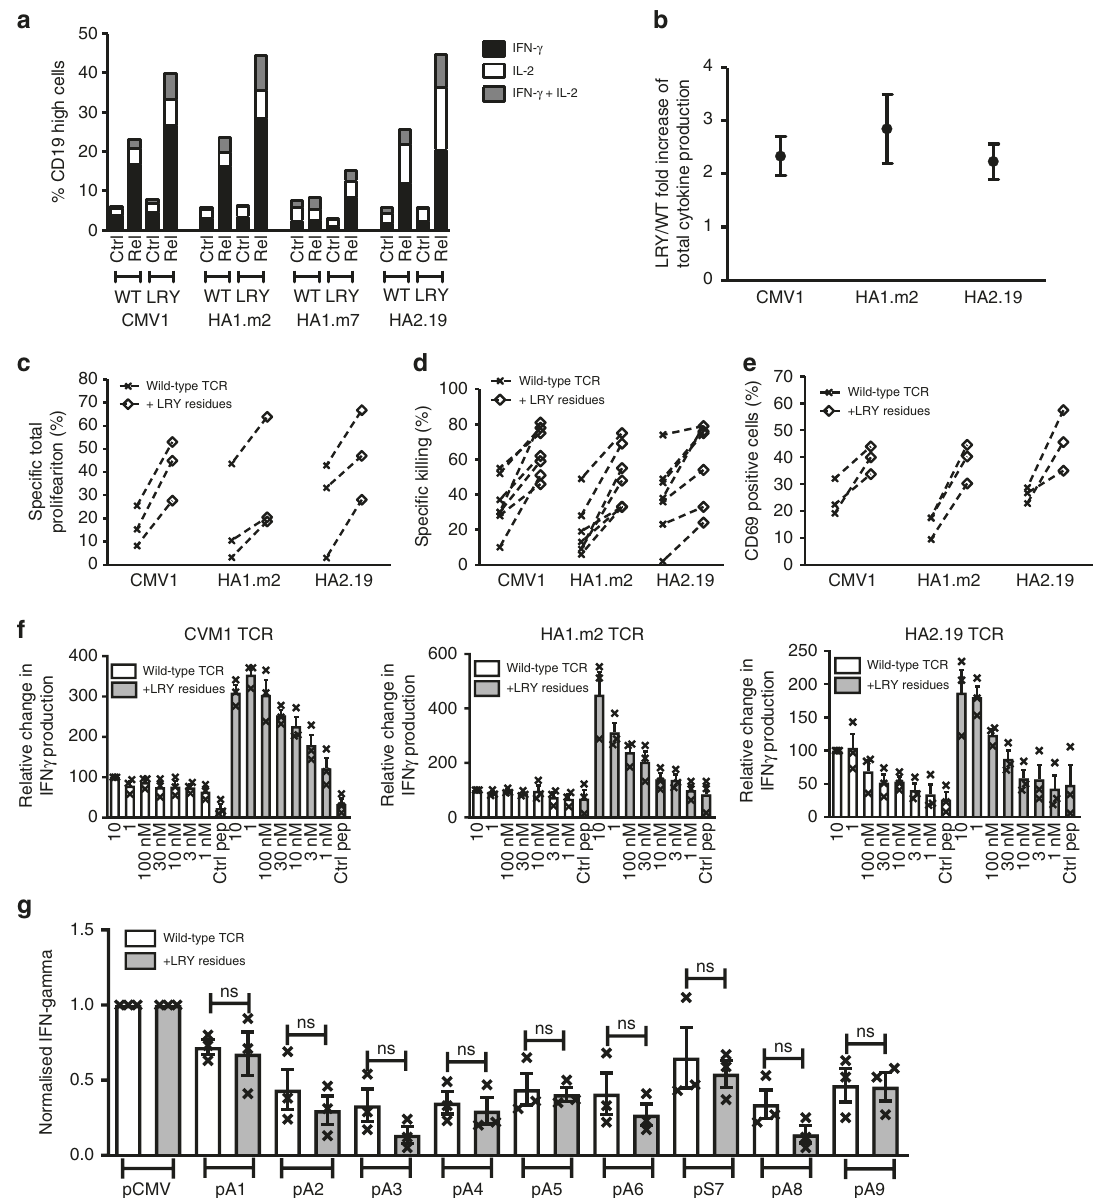
Fig. 7 Residues L96 α , R9 β , and Y10 β enhance antigen-speci fi c effector functions. Human T cells transduced with wild-type or L96 α , R9 β , and Y10 β (LRY)- modi fi ed TCRs were stimulated with peptide-loaded T2 cells. a A representative example of n = 3 independent experiments showing the frequencies of gated CD19 high T cells that produced IFN γ and/or IL2. b Pooled data (means ± SEM) showing the fold increase in total speci fi c cytokine production by LRY- modi fi ed TCR-transduced cells over the corresponding wild-type TCR-transduced cells. n = 3 independent experiments. Cytokine produced by stimulation with the irrelevant peptide were subtracted from cytokine produced by cognate peptide. c Transduced T cells labeled with Cell Trace Violet were co- cultured for 5 days with peptide-loaded T2 cells. Shown are the percentages of wild-type or LRY-modi fi ed TCR-transduced CD8 + T cells that underwent antigen-speci fi c proliferation. Proliferation arising from irrelevant peptide stimulation was subtracted from cognate peptide-induced proliferation. n = 3 independent experiments. d The indicated transduced T cells were co-cultured overnight with T2 cells pulsed with control peptide or cognate peptide. Shown is the antigen-speci fi c killing of n = 7 independent experiments for the CMV1 TCR and n = 6 independent experiments for the HA1.m2 and HA2.19 TCRs. e Transduced T cells were co-cultured for 4 h with peptide-loaded T2 cells. Shown are n = 3 independent experiments measuring antigen-speci fi c upregulation of CD69 on CD8 + T cells expressing wild-type or LRY-modi fi ed TCRs. CD69 expression in response to irrelevant peptide stimulation was subtracted from cognate peptide induced CD69 expression. f Transduced T cells were stimulated overnight with T2 cells loaded with the indicated concentrations of cognate peptide. IFN γ production was measured by ELISA. Data were pooled (means ± SEM) and normalized to IFN γ production by wild- type TCR-transduced T cells stimulated with T2 cells loaded with 10 μ M cognate peptide. n = 3 independent experiments. g CMV1 TCR-transduced T cells were stimulated overnight with T2 cells expressing variant or cognate peptide. IFN γ production was measured by ELISA. Data were pooled (means ± SEM) and normalized to IFN γ produced in response to cognate peptide stimulation. n = 3 independent experiments. ns (non-signi fi cant), P > 0.05 (Mann – Whitney U test) for all comparisons between the LRY-modi fi ed TCR and the wild-type